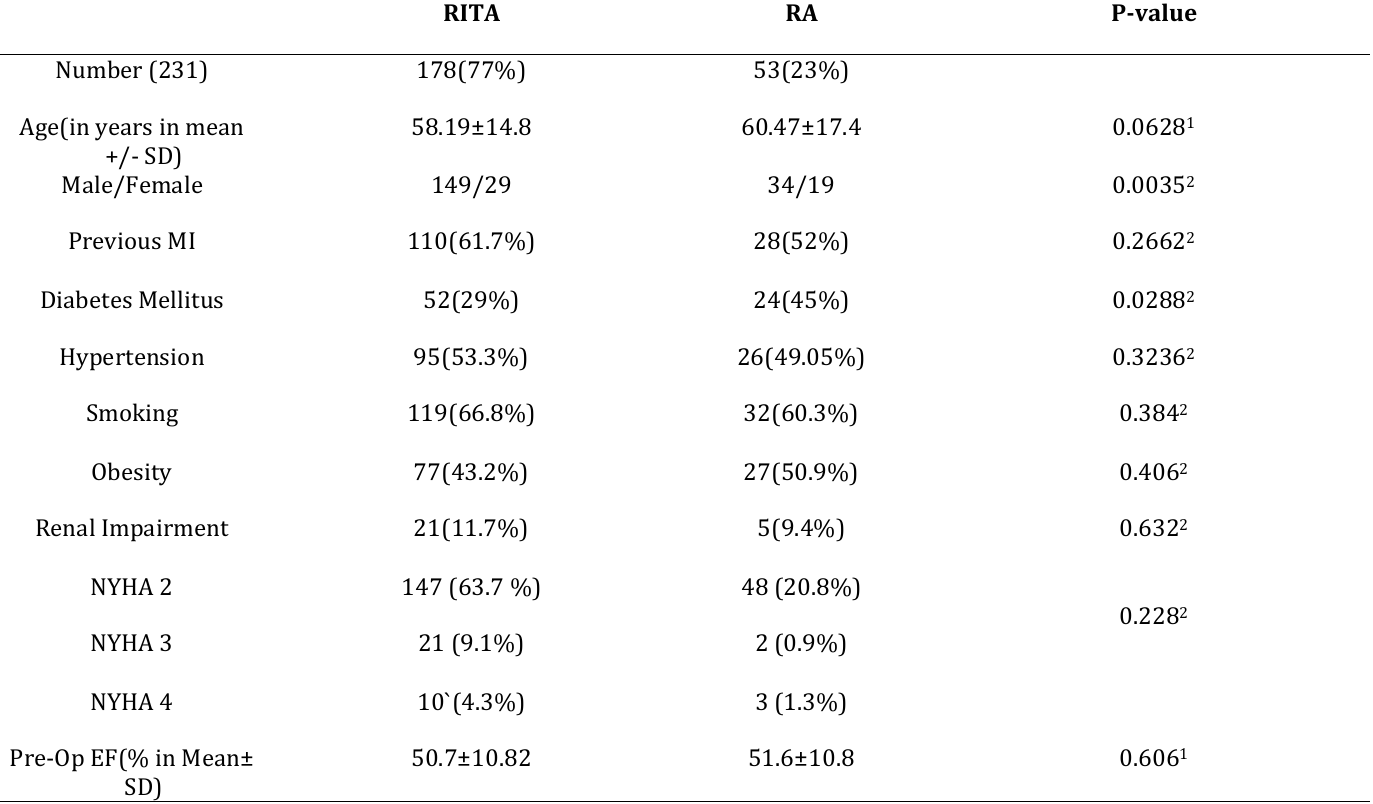
Table 1. Comparison of pr-operative variables between RITA and RA groups